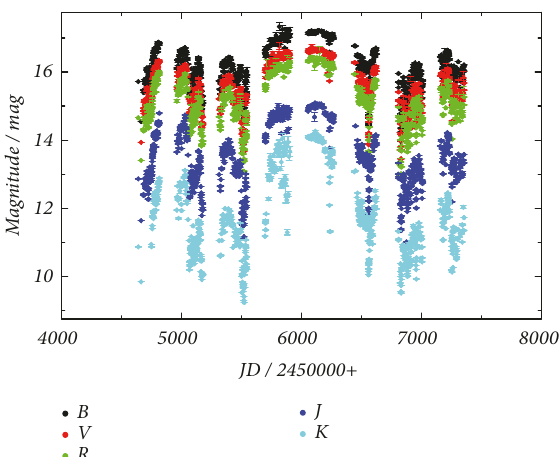
Figure 1: The BVRJK lightcurvesof 3C454.3. The black dots stand for B band, the red dots stand for V band, the green dots stand for R band, the blue dots stand for J band, and the cyan dots stand for K